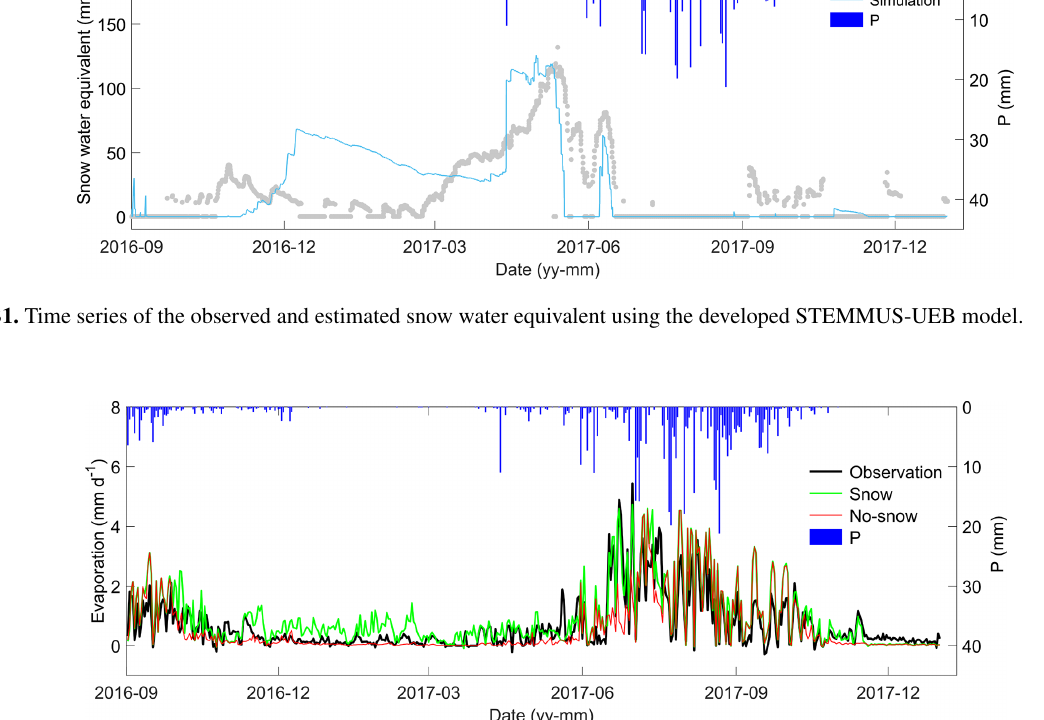
Figure B2. Intercomparison of the observed and estimated surface evaporation using the model with and without the snow module.